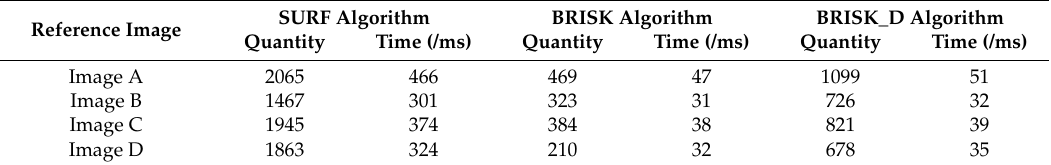
Table 1. The comparison about feature points extracted by each algorithm and their time consumption.